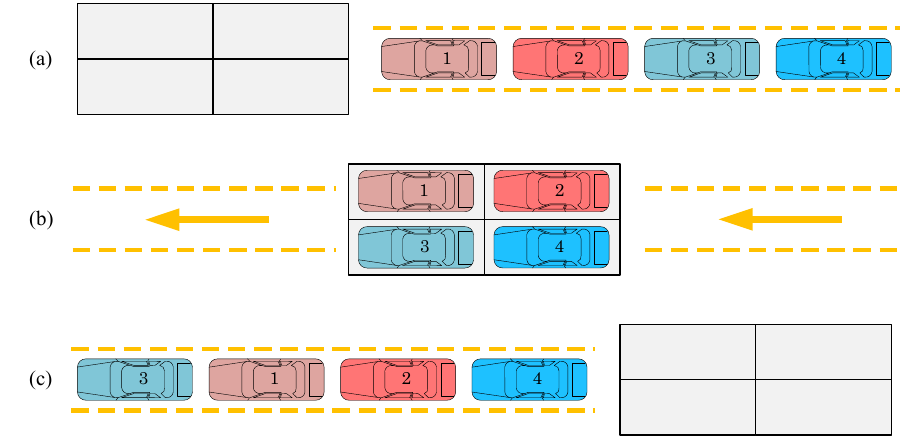
Figure 2. An example of selectivity bank with two